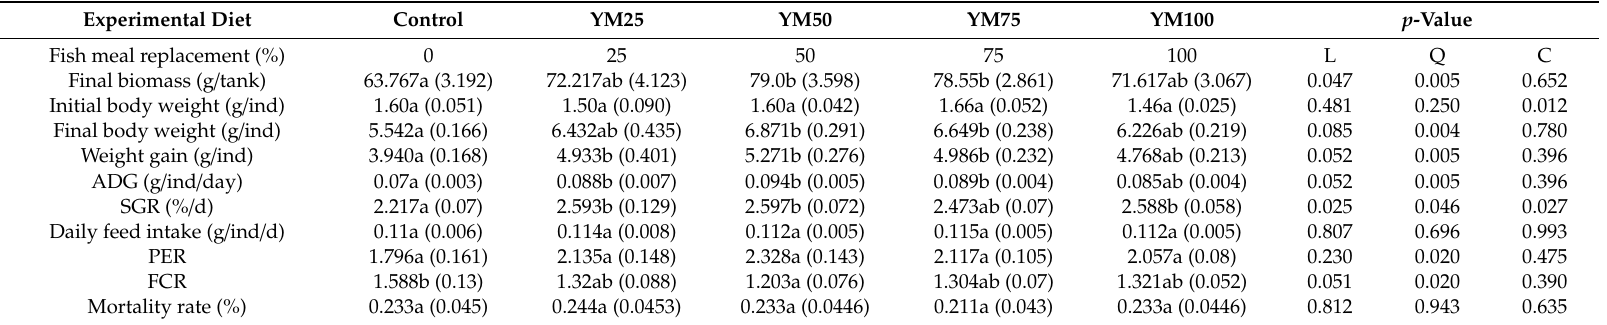
Table 3. Growth, feed intake, and use, as well as mortality rates, among di ff erent fishmeal replacement diets (n = 6). Experimental